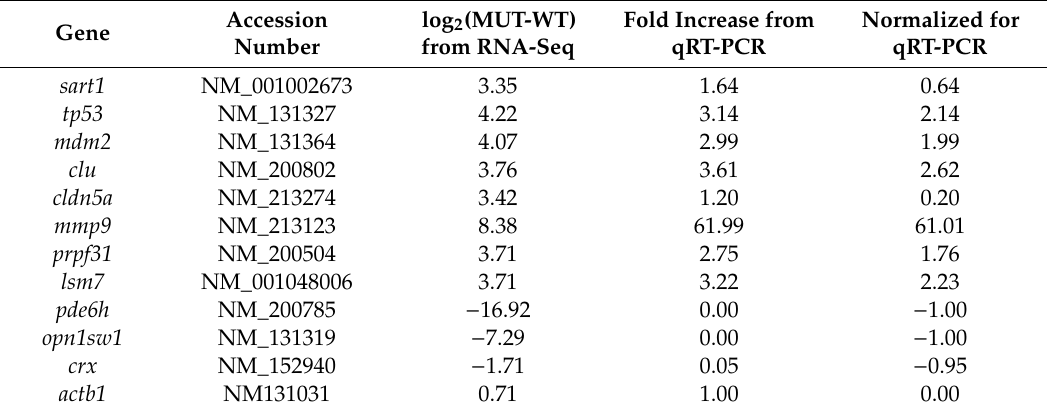
Table 4. Upregulated and downregulated genes confirmed by